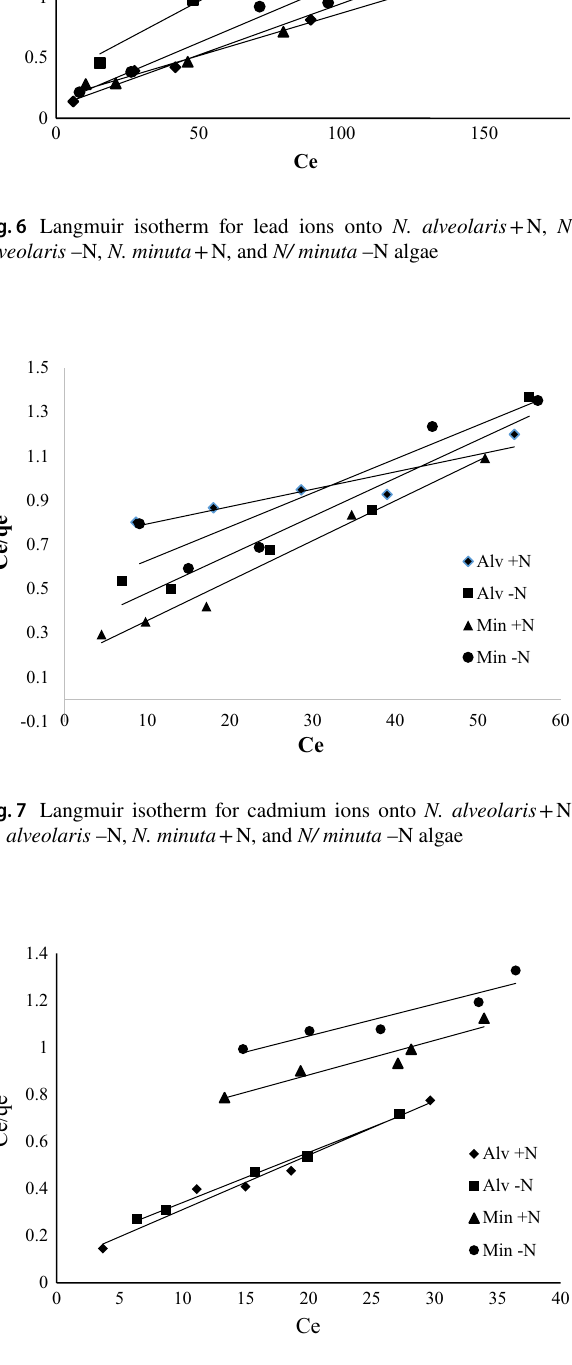
Fig. 8 Langmuir isotherm for zinc ions onto N. alveolaris + N, N. alveolaris